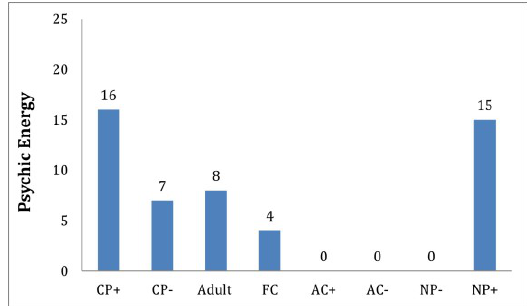
Chart 7: Egogram Teacher 3 with Student 3